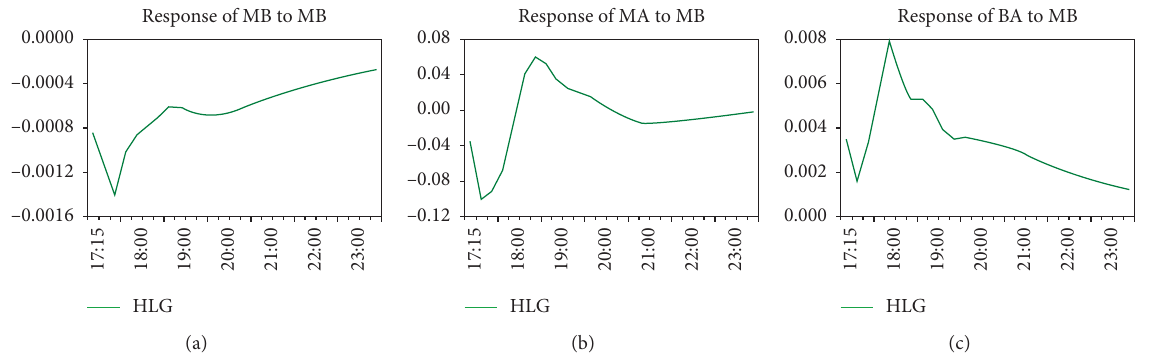
Figure 6: Response to the impact of GM metro boarding volume at 17: 00. (a) Response of MB to MB. (b) Response of MA to MB. (c) Response of BA to MB.